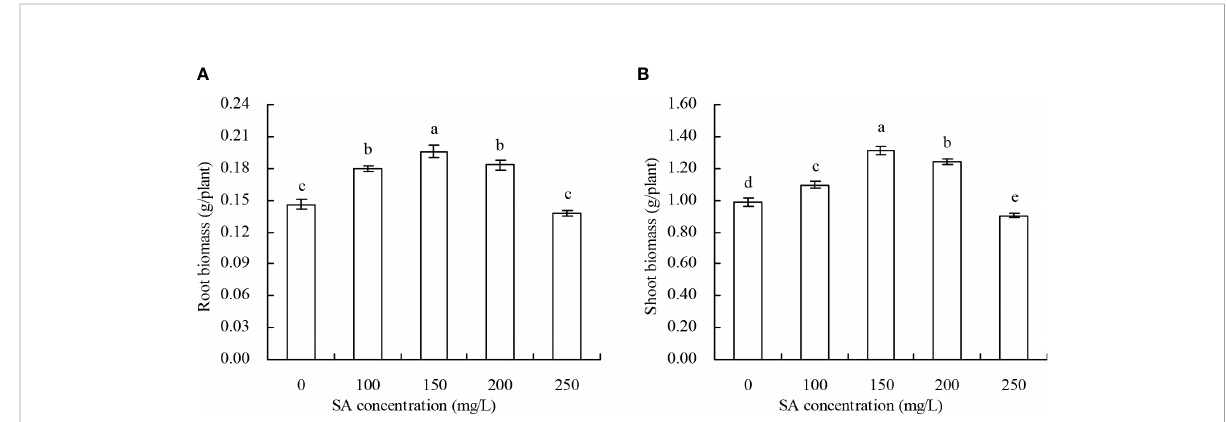
FIGURE 1 Biomass of Nasturtium of fi cinale . (A) Root biomass; (B) shoot biomass. Data shown are mean values ( ± SE) of three replicates. Different lowercase letters indicate signi fi cant differences among the treatments (Duncan ’ s Multiple Range Test, P <